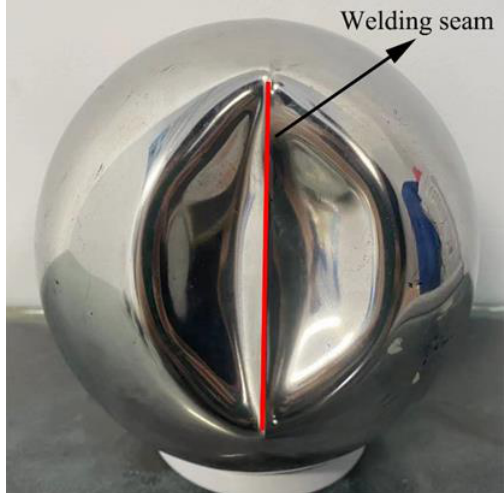
Figure 10. Collapse mode of spherical shell.